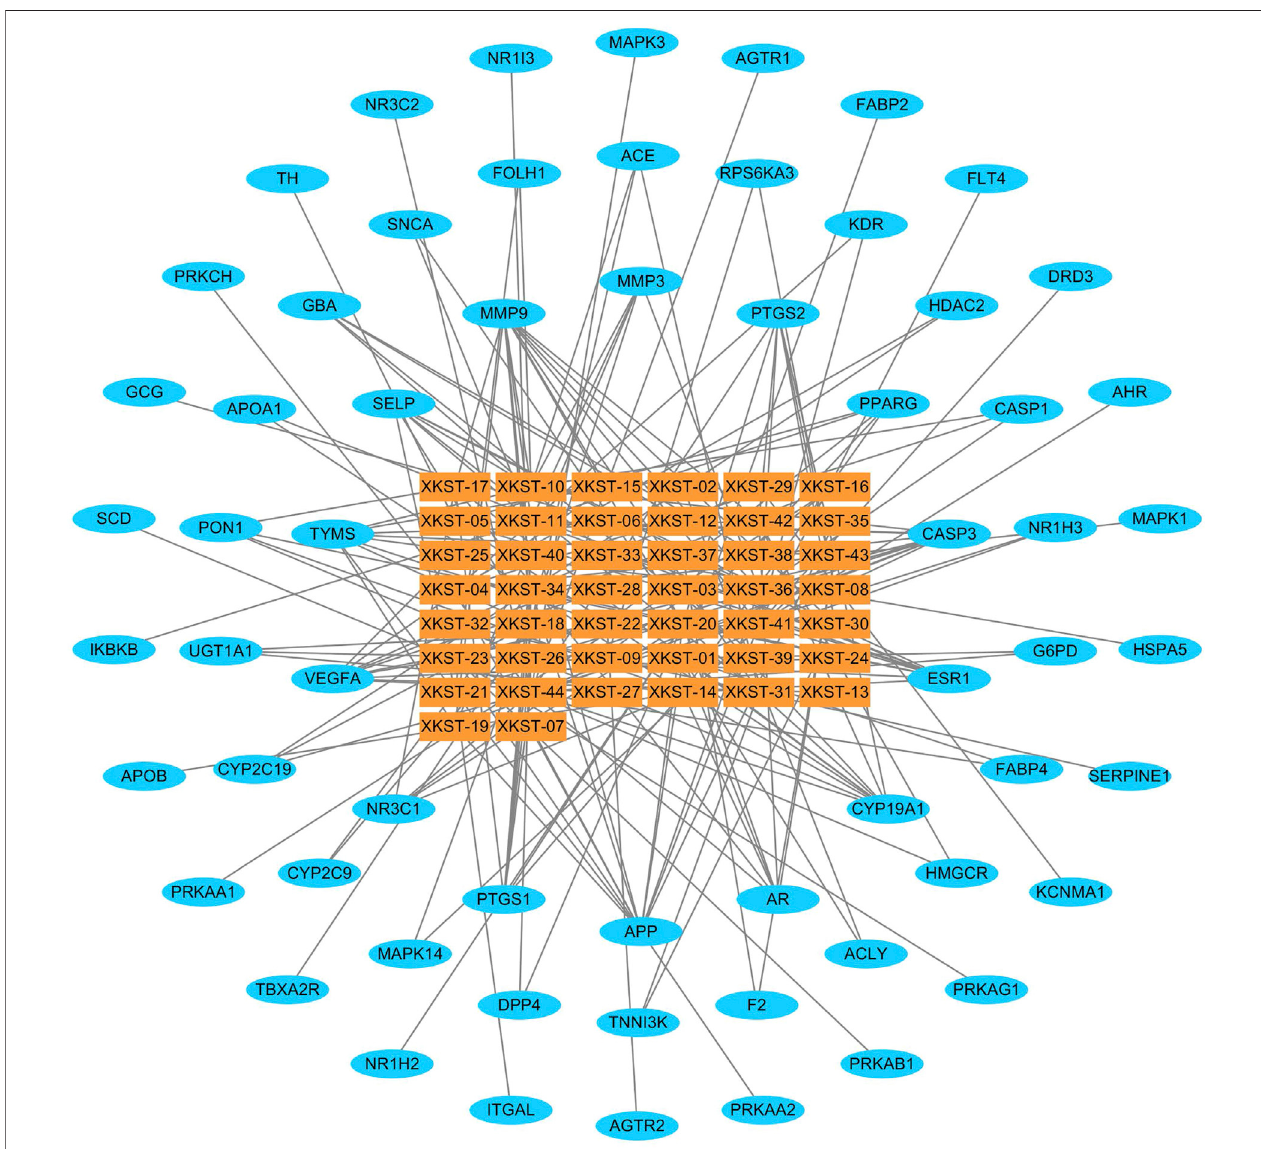
FIGURE 5 | Compound – target network of